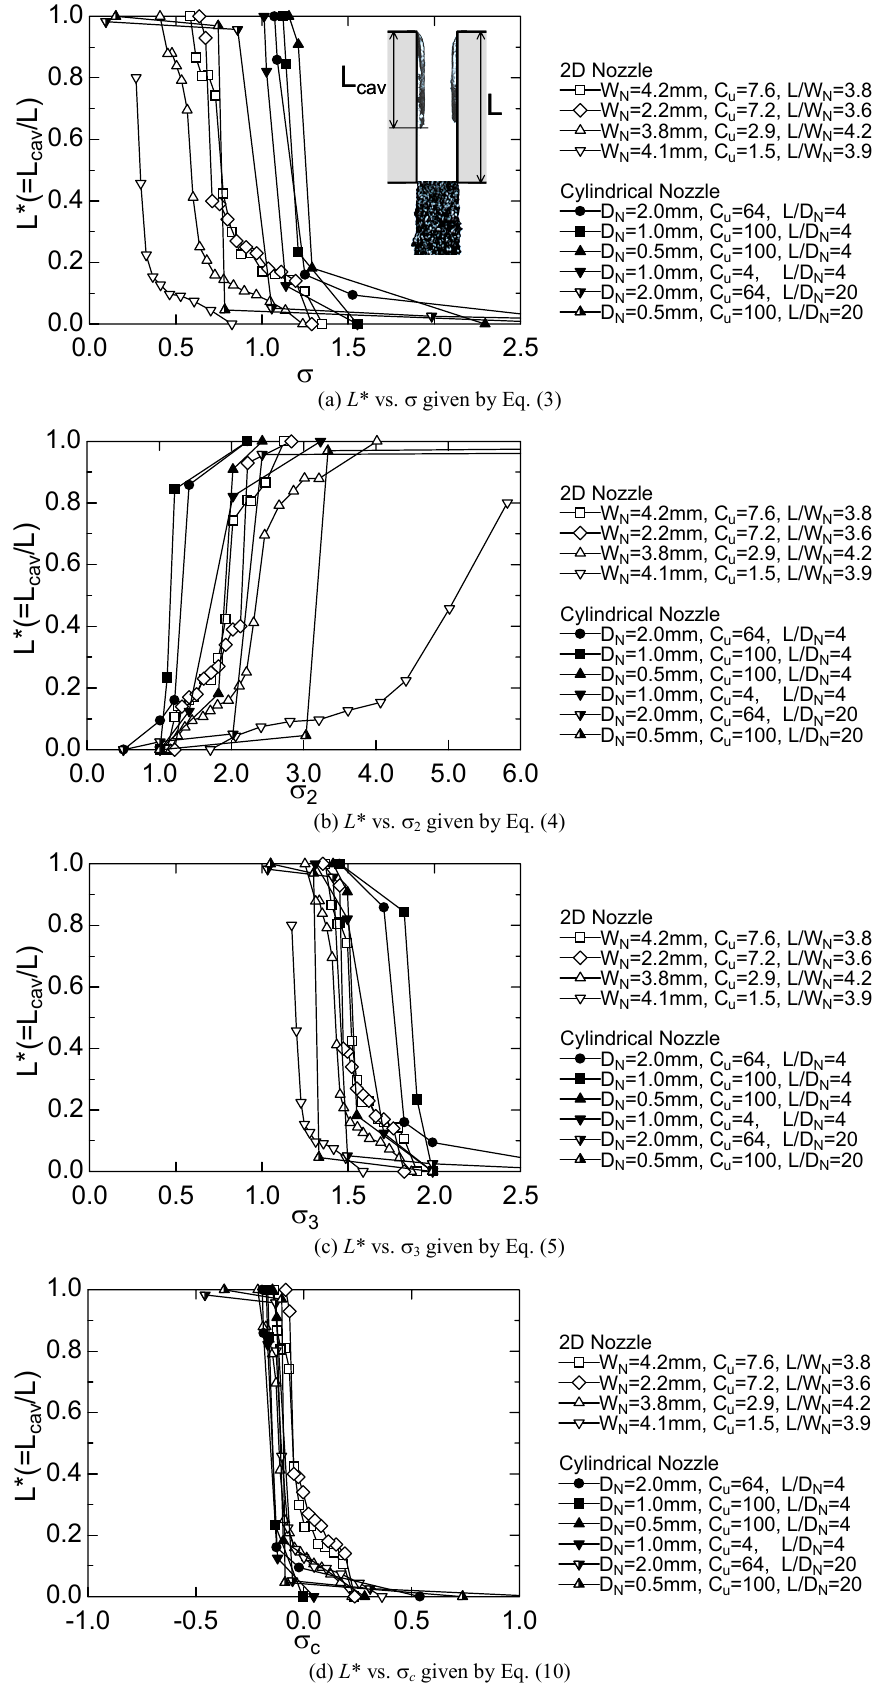
Fig. 8 Relation between L * (= L cav / L ) and the cavitation